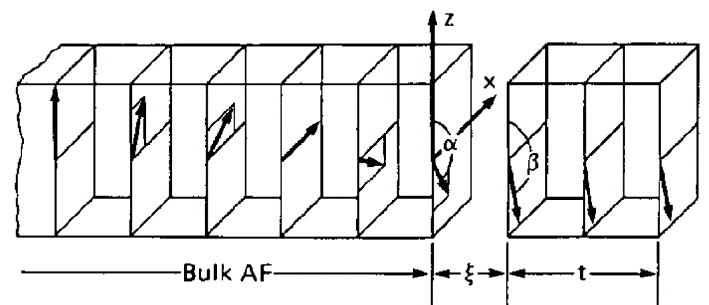
Figure 2. Magnetic model of a bulk antiferromagnet (AFM) (only one sublattice’s spins are shown) in contact with a FM thin film. Here, the uniaxial AFM anisotropy is oriented along the positive z-direction, while the external magnetic field is oriented along the negative z-direction. Reprinted with permission from [37], Copyright 2001 AIP Publishing.